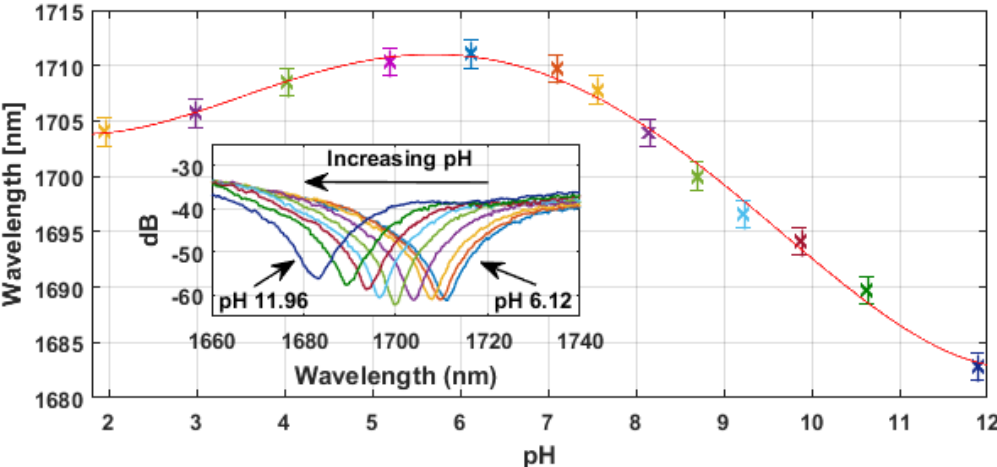
Figure 8. Spectral response from a 1.4-BDDA/PIP polymer coated inline sensor when submerged in liquids with pH-levels ranging from 1.95 to 11.89. The wavelength of the central minima as a function of pH is shown in the inset for pH 6.12 to 11.89.